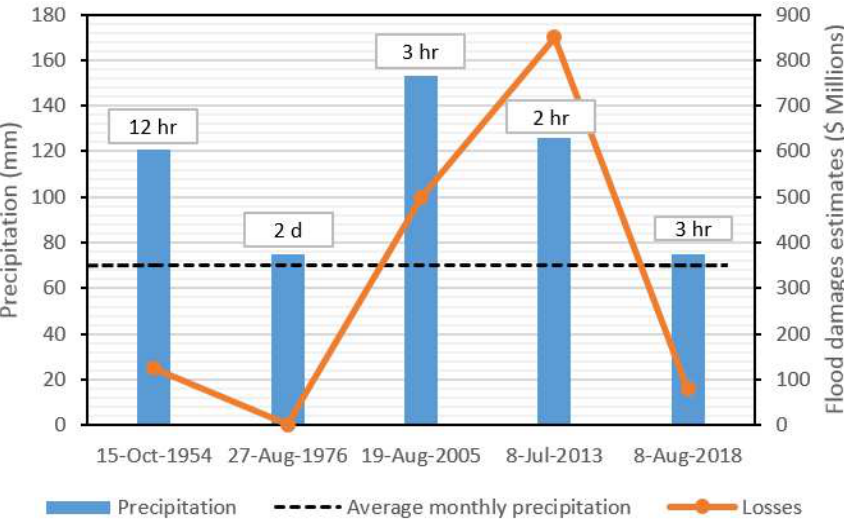
Figure 1. Major flood events in Toronto in the last century.